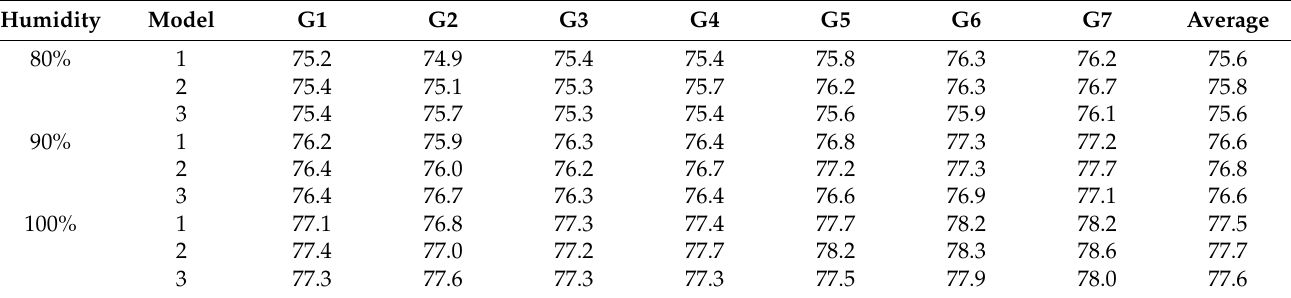
Table 5. THI of groups in models at v = 6 m/s.